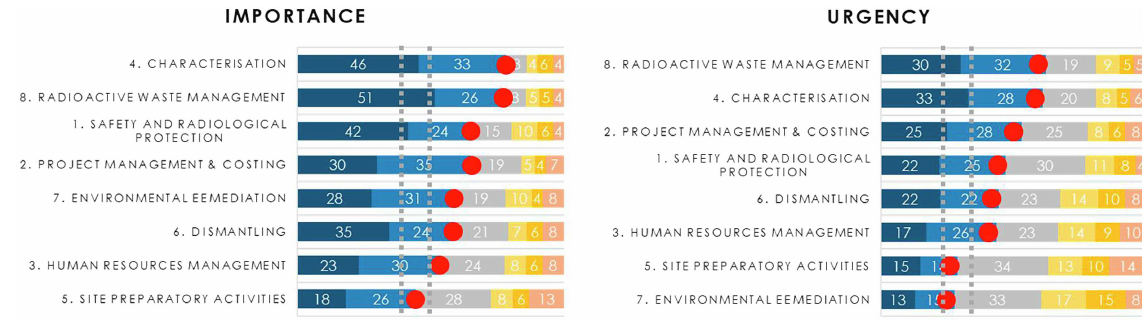
Fig. 7. Results of the questionnaire survey for the thematic